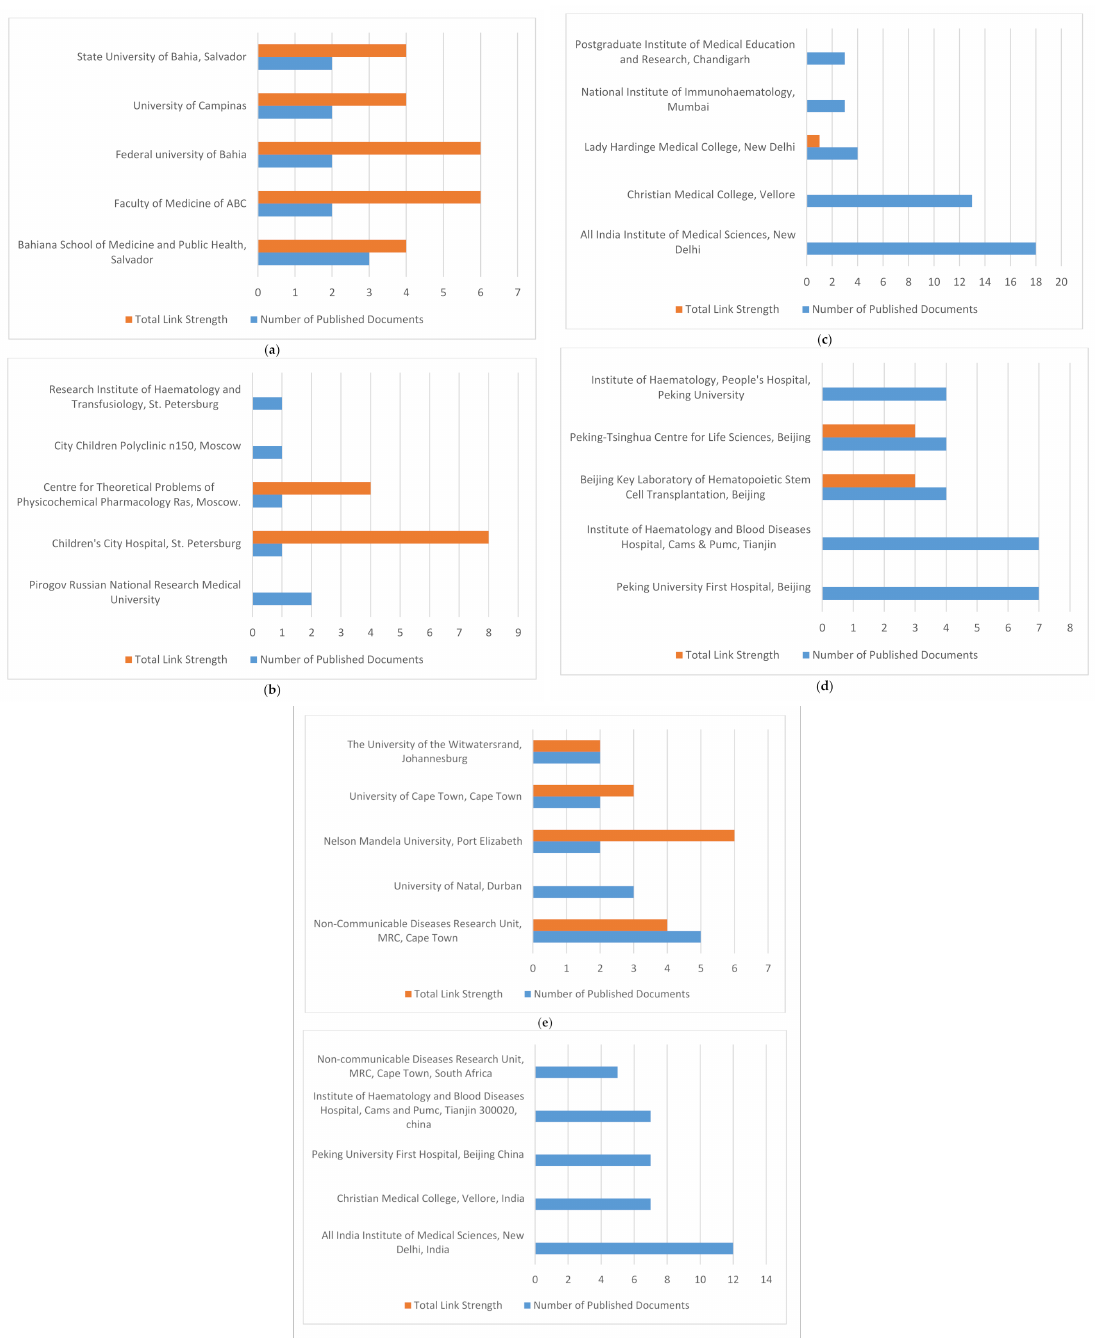
Figure 7. ( a ) Organisations with highest number of anaemia publications: Brazil. ( b ) Organisations with highest number of anaemia publications: Russia. ( c ) Organisations with highest number of anaemia publications: India. ( d ) Organisations with highest number of anaemia publications: China. ( e ) Organisations with highest number of anaemia publications: South Africa. ( f ) Organisations with highest number of anaemia publications: